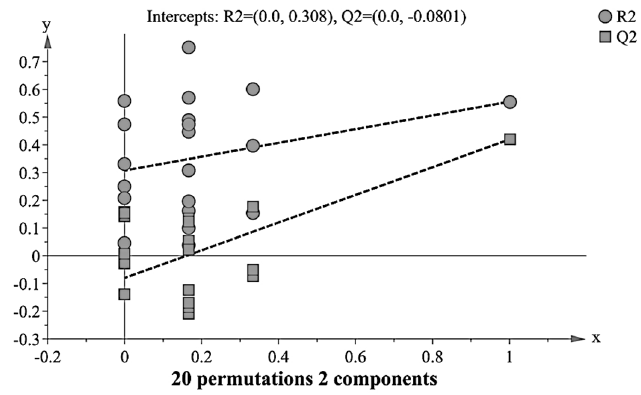
Figure 6. Model validation assessed by 20 permutation tests (R2 = (0.0, 0.308) Q2 = (0.0, −0.0801).